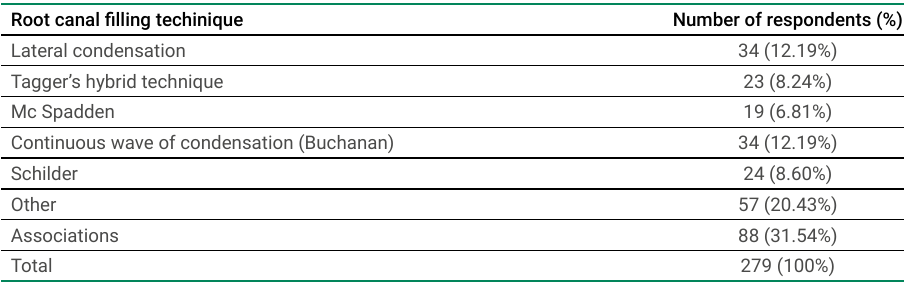
Table 3. Root canal filling techniques used either in isolation or